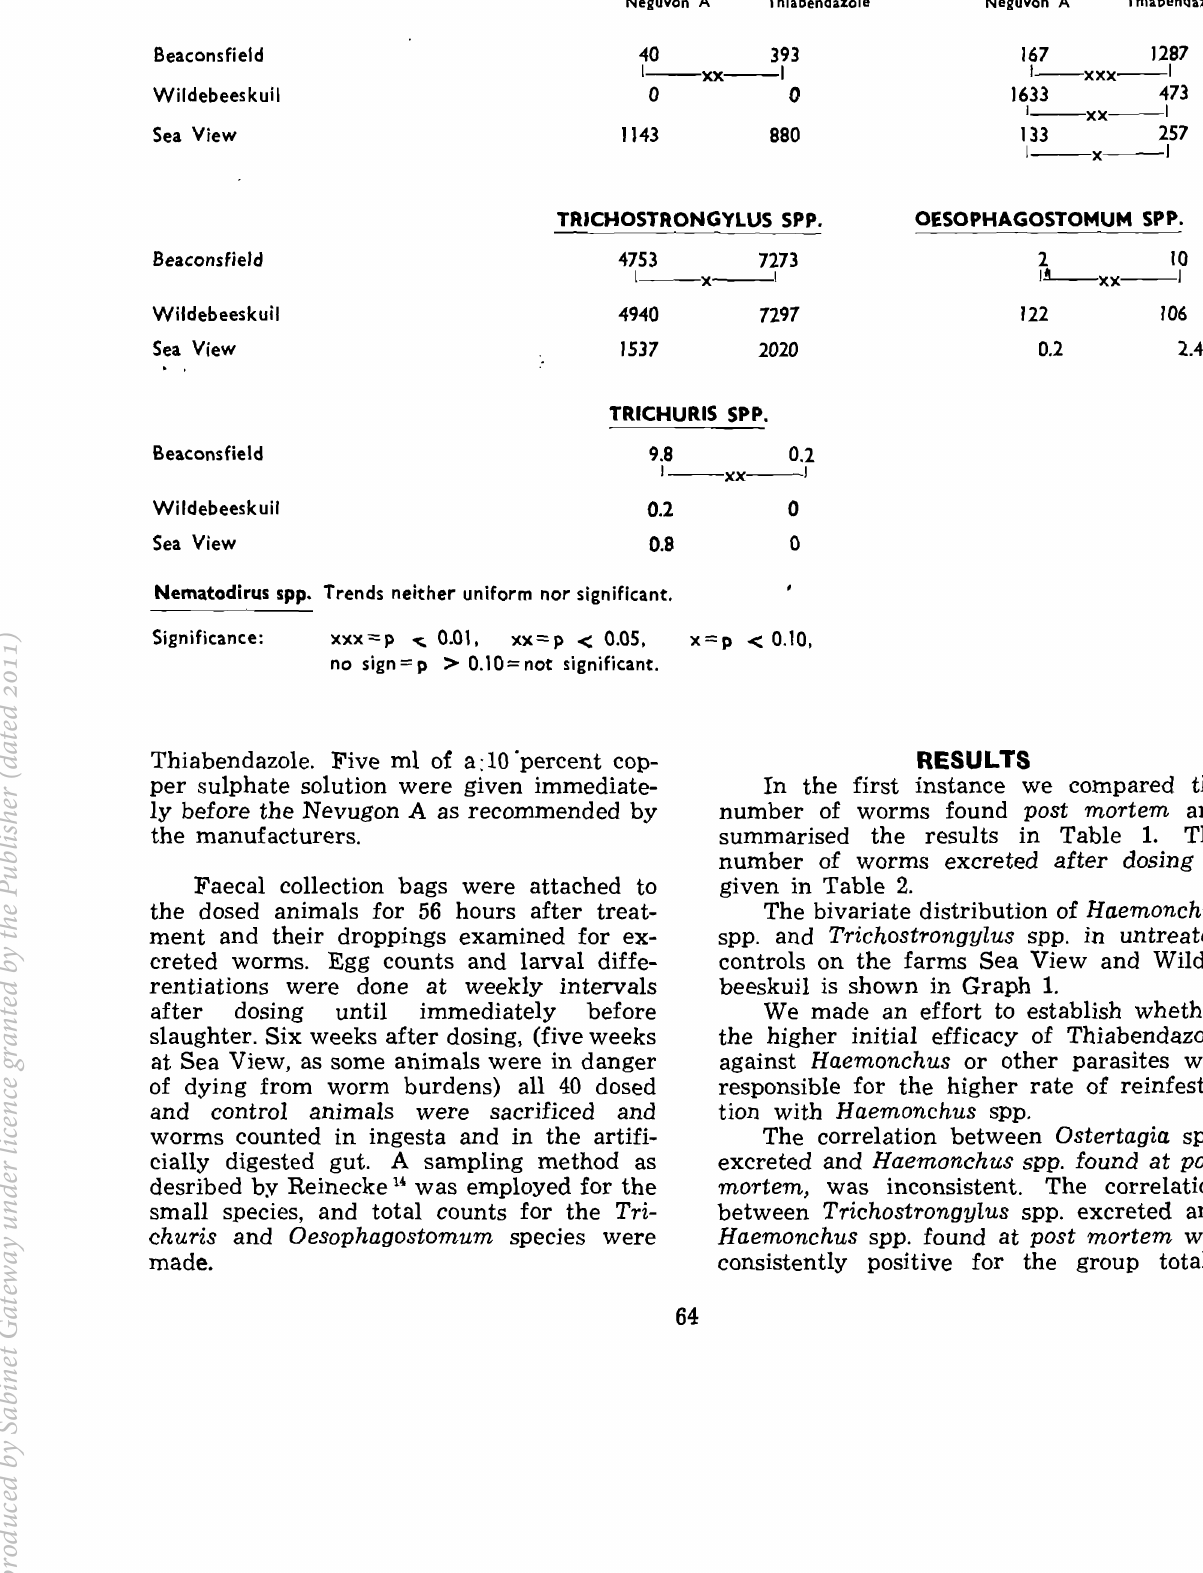
Table 2-WORMS EXCRETED PER SHEEP (AVERAGE PER GROUP OF 5 SHEEP) AND SIGNIFICANCE OF DIFFERENCES ACCORDING TO